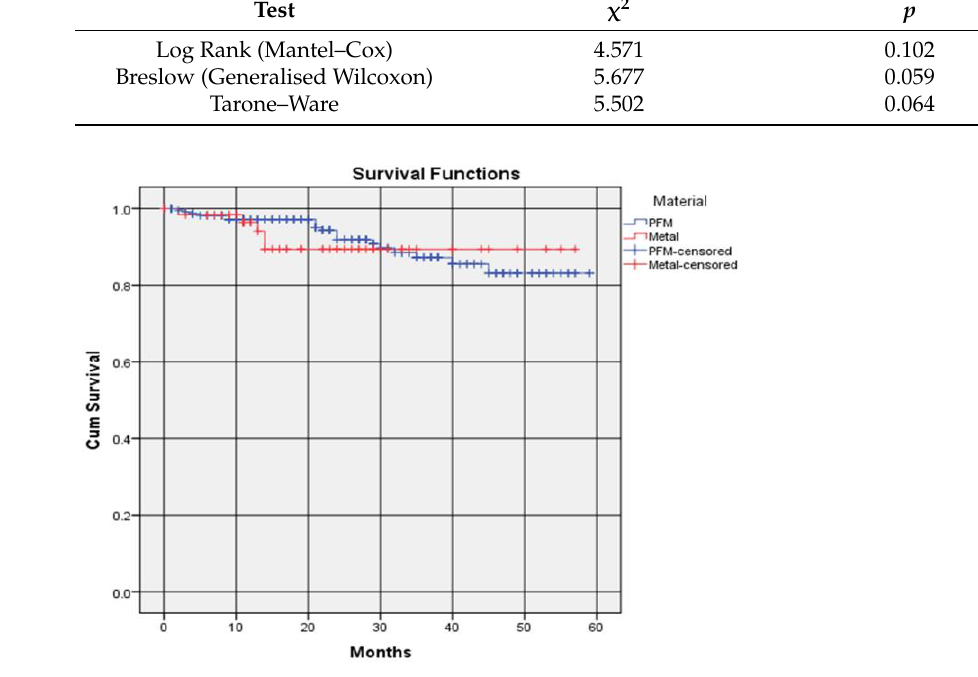
Figure 4. Survival rate of crowns according to material. Table 6. Test of survival distributions for two different crown